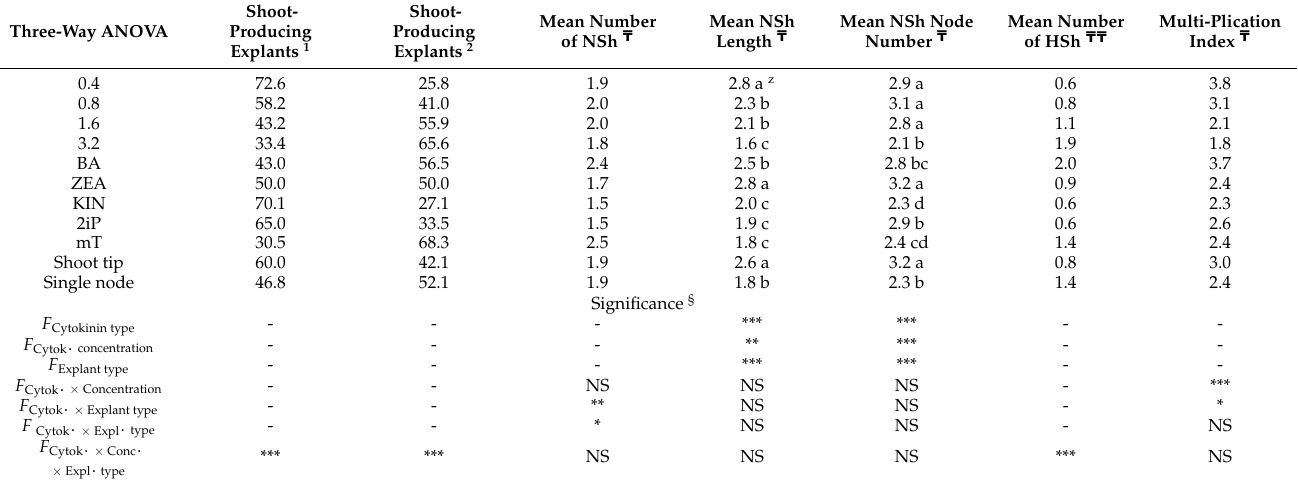
Figure 3. Typical responses of shoot tip and single node explants excised from in vitro seedlings of Salvia spp., during the in vitro establishment stage on hormone-free MS medium. Size bars = 1.0 cm. NSh = normal shoot. HSh = hyperhydrated shoot. × mean node number